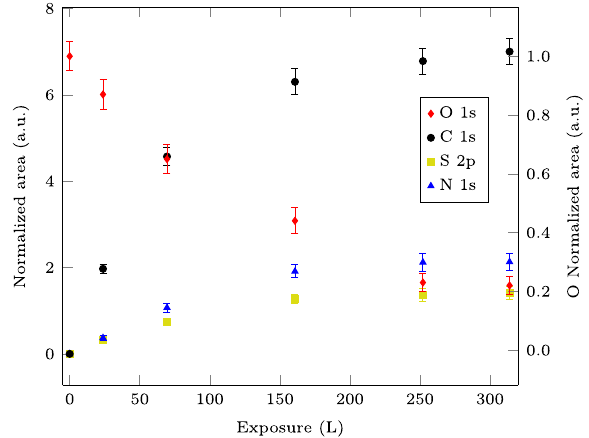
Fig. 4 Growth kinetics of 2-MBI at RT on the pre-oxidized Cu(111) (2D oxide). Evolution of the C 1s, S 2p, N 1s and O 1s normalized areas with 2-MBI exposure. The error bars were estimated by adjusting the fi t of the XPS core